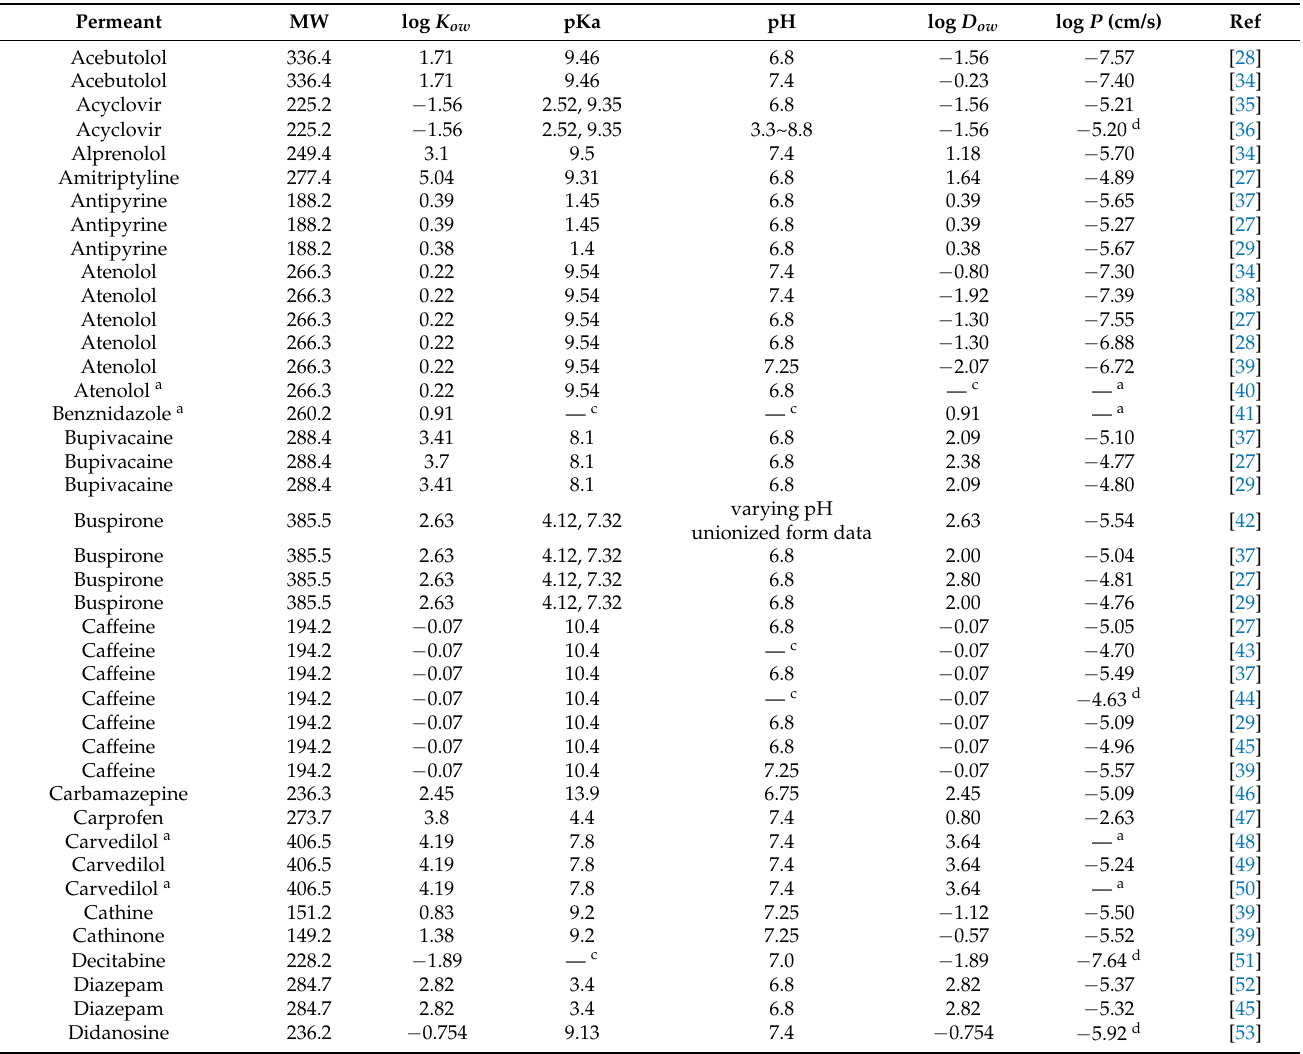
Table A1. Properties of permeants (MW, log K ow , and pKa), permeability coefficients, and sources of buccal permeation data. Permeant Acebutolol